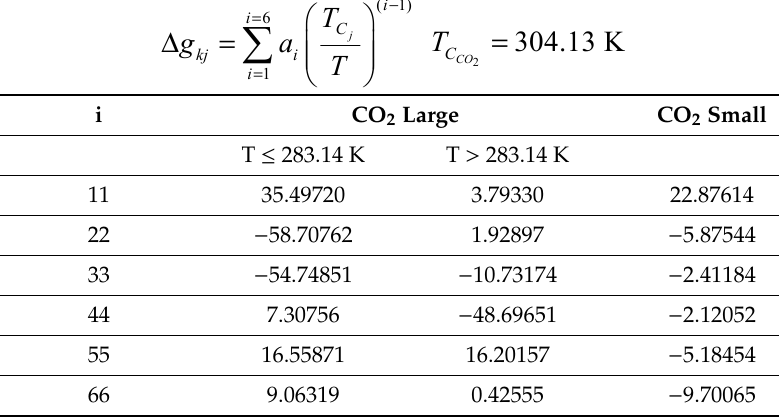
Table 2. Coefficients for free energy of guest type j inclusion in cavity type Table 2. Coe ffi cients for free energy of guest type j inclusion in cavity type k.